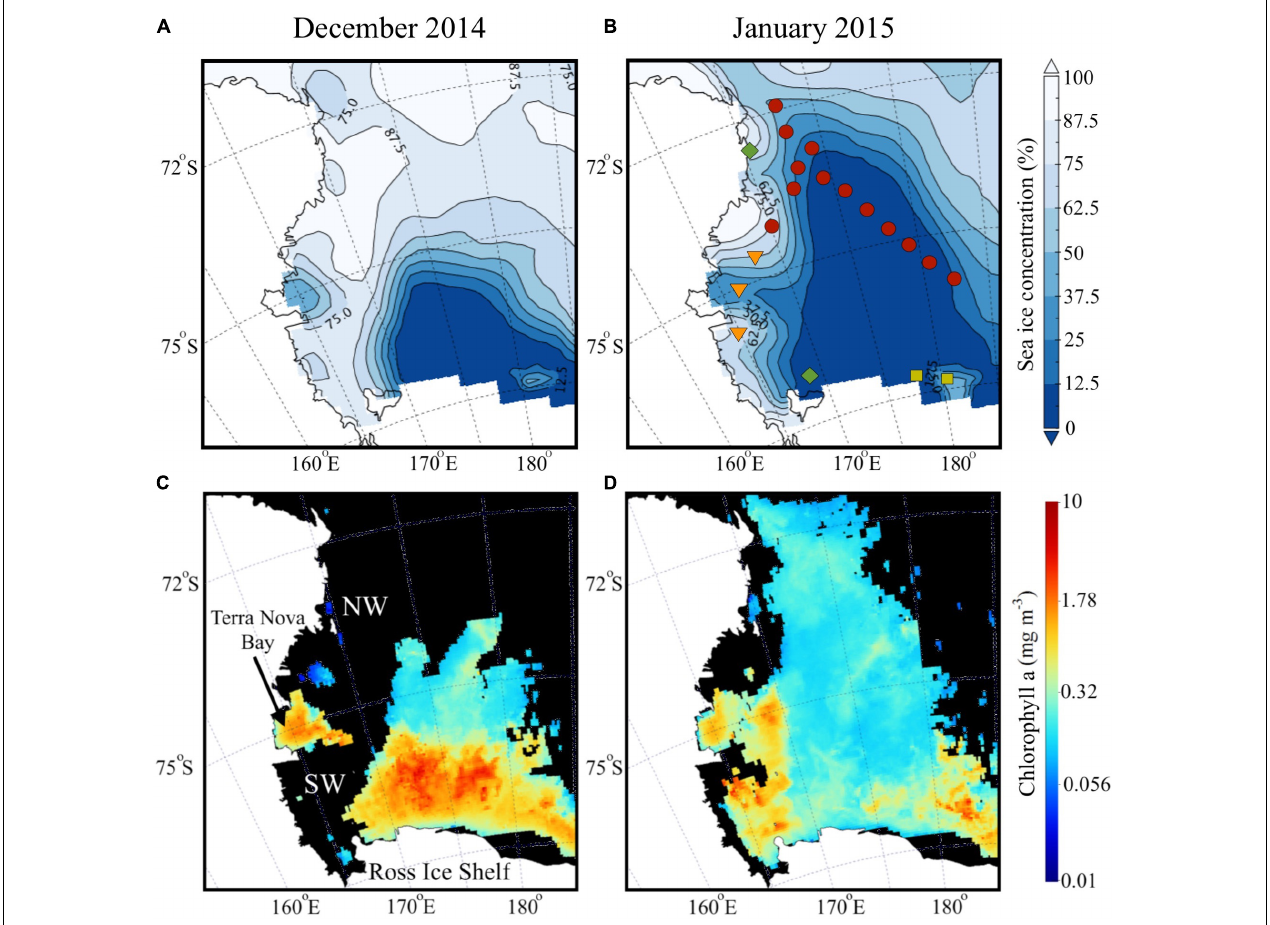
FIGURE 2 | Satellite imagery during austral summer. Average surface distribution of satellite-derived (A,B) sea ice concentration (%) and (C,D) chlorophyll a (mg m - 3 ) during austral summer (December 2014 and January 2015).